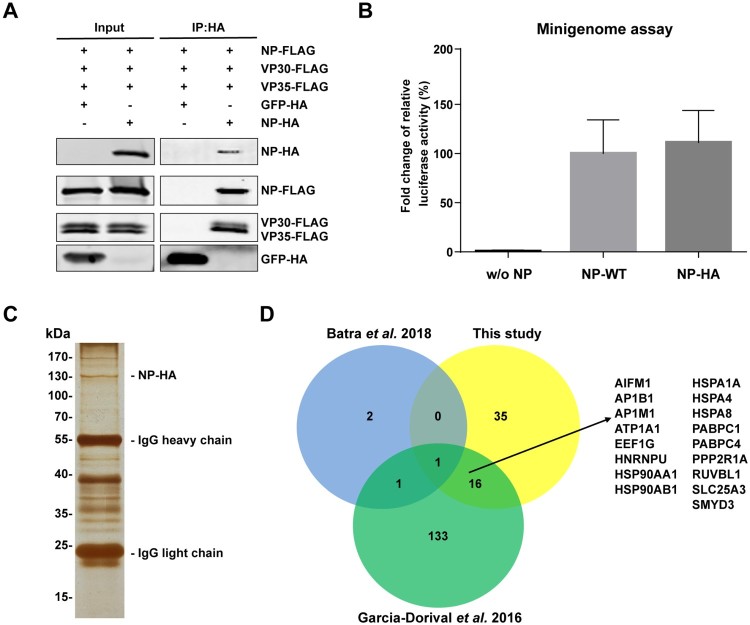
Identification of host proteins associated with transcription and replication competent polymerase complex of EBOV. (A) C-terminal HA-tagged NP interacted with other viral proteins of EBOV polymerase complex. Plasmids encoding GFP-HA (negative control) or NP-HA were co-transfected separately with NP-FLAG, VP35-FLAG and VP30-FLAG into HEK293T cells. At 48 h post-transfection (p.t.), cells were collected, followed by anti-HA co-IP assay and western blotting. Representative results of 3 independent experiments are shown. (B) NP-HA rescued EBOV replication in the minigenome system. Plasmids of EBOV viral proteins (VP35, VP30, L, and empty vector, non-tagged NP or NP-HA), T7 polymerase, EBOV minigenome and pGL4 were co-transfected into HEK293T cells. At 48 h p.t., cells were collected, followed by dual-luciferase assay. The ratio of Renilla to Firefly luciferase activity of lysates from cells transfected with non-tagged NP was set to 100%. The mean and SEM from one representative experiment (n = 3) of 3 independent experiments are indicated. (C) Immunoprecipitation of host proteins associated with EBOV polymerase complex using NP-HA as bait. Plasmids expressing NP-HA, VP35, VP30, L, T7 polymerase and EBOV minigenome were co-transfected into HEK293T cells. At 48 h p.t., cells were lysed, followed by anti-HA immunoprecipitation. Eluate was separated by SDS-PAGE and visualized by silver staining. (D) Venn diagram showing the overlap of candidate host proteins interacting with NP between this study and two previous studies. Seventeen proteins that were identified both in our study and the study by Garcia-Dorival et al. are listed [30].